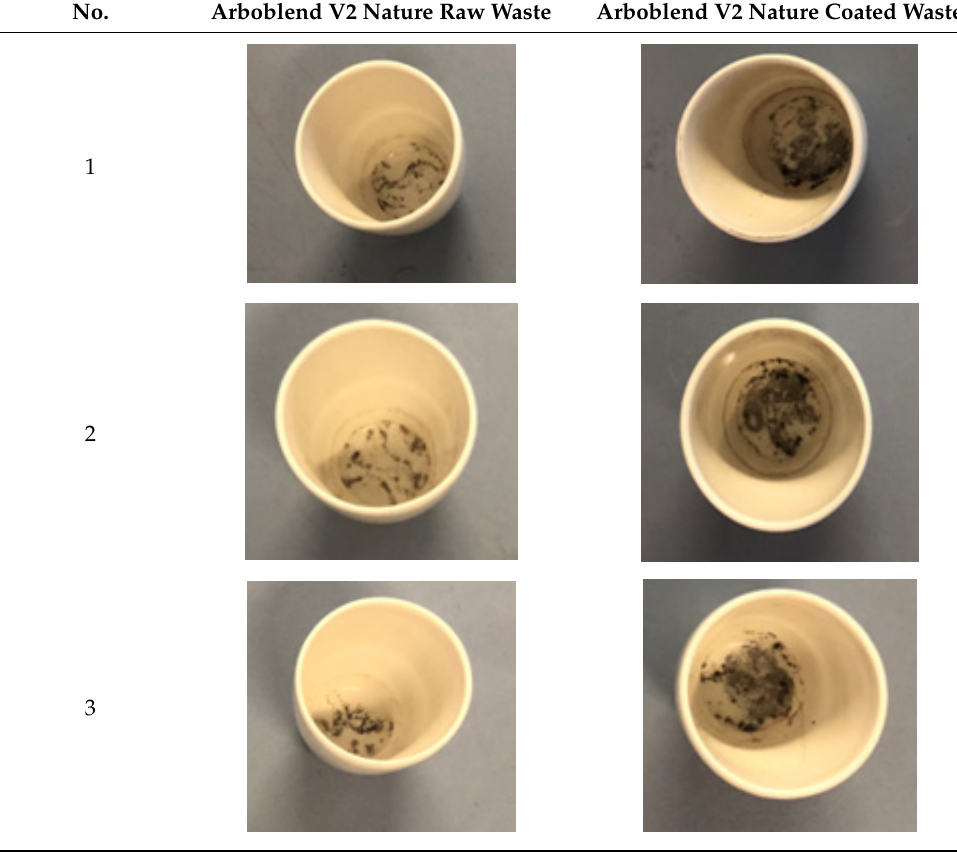
Figure 7. DSC test for silver nano-coated Arboblend V2 sample.